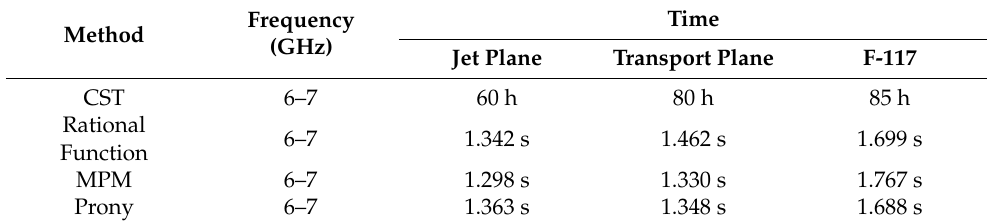
Table 2. Simulation time comparison among CST and prediction theories.